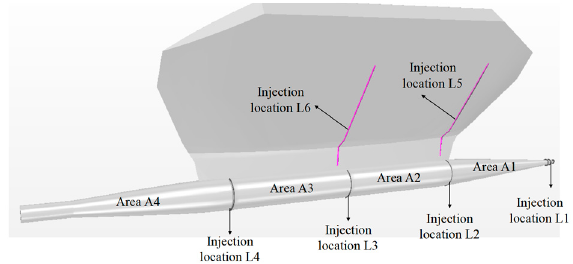
Figure 3. Air injection locations and areas.